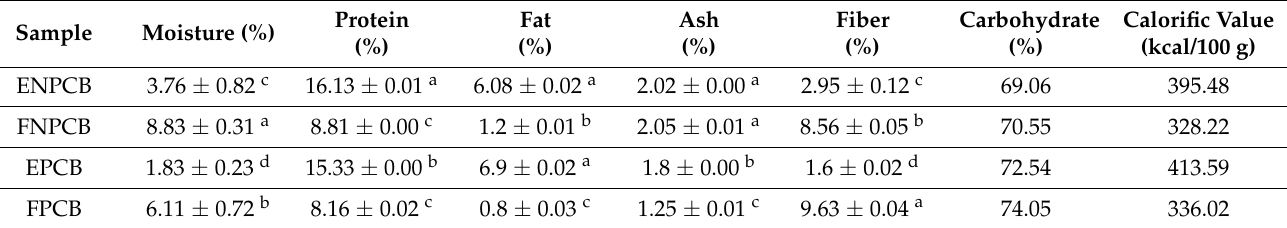
Table 6. Chemical composition and calorific value of gluten-free cereal